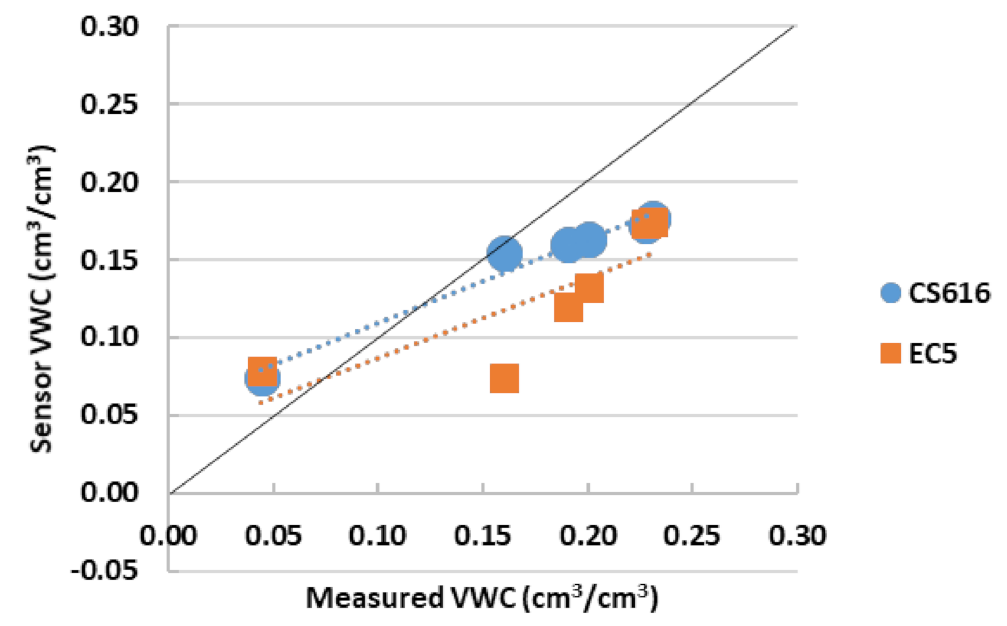
Figure 4. Comparison of CS616 and EC5 with soil sampling method for sandy clay